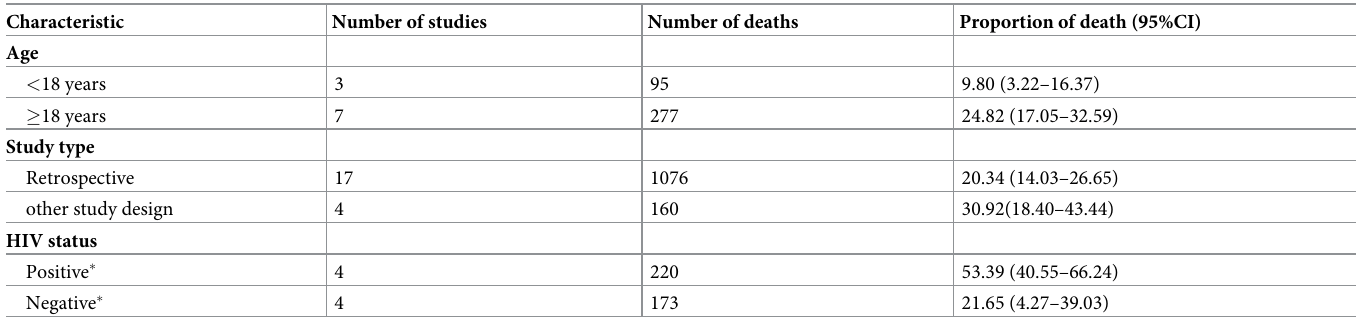
Table 2. Sub group analysis of